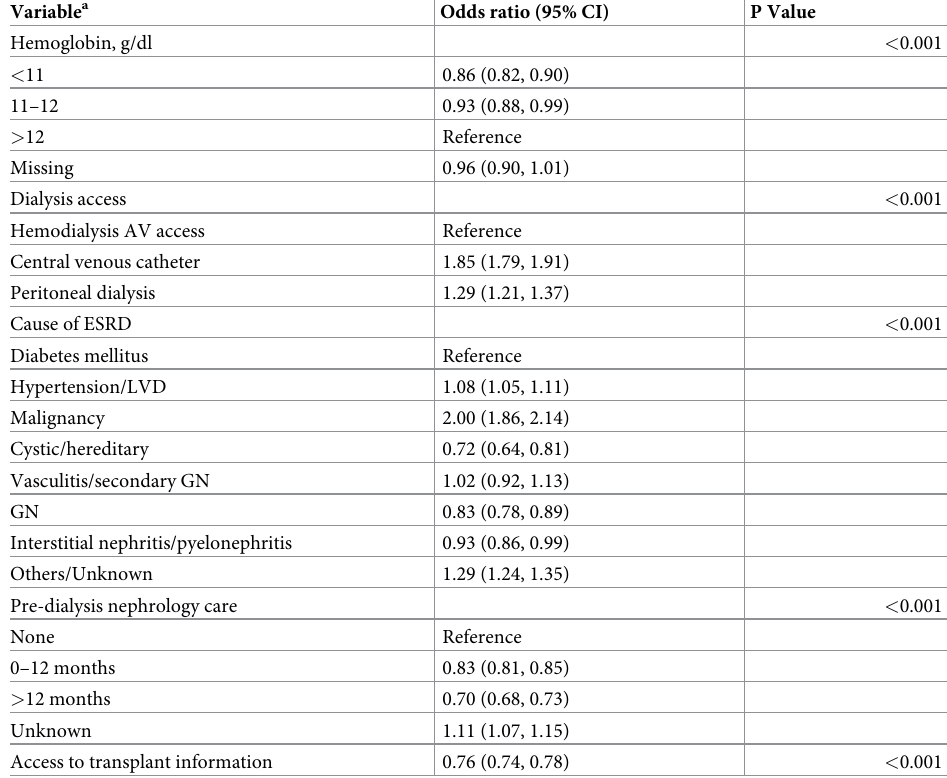
represents unadjusted survival curves for patients with and without pre-dialysis acute hospital- ization by type, censored on 31 December 2015. Fig 3B represents unadjusted survival curves for patients without pre-dialysis hospitalization and those with multiple episodes of